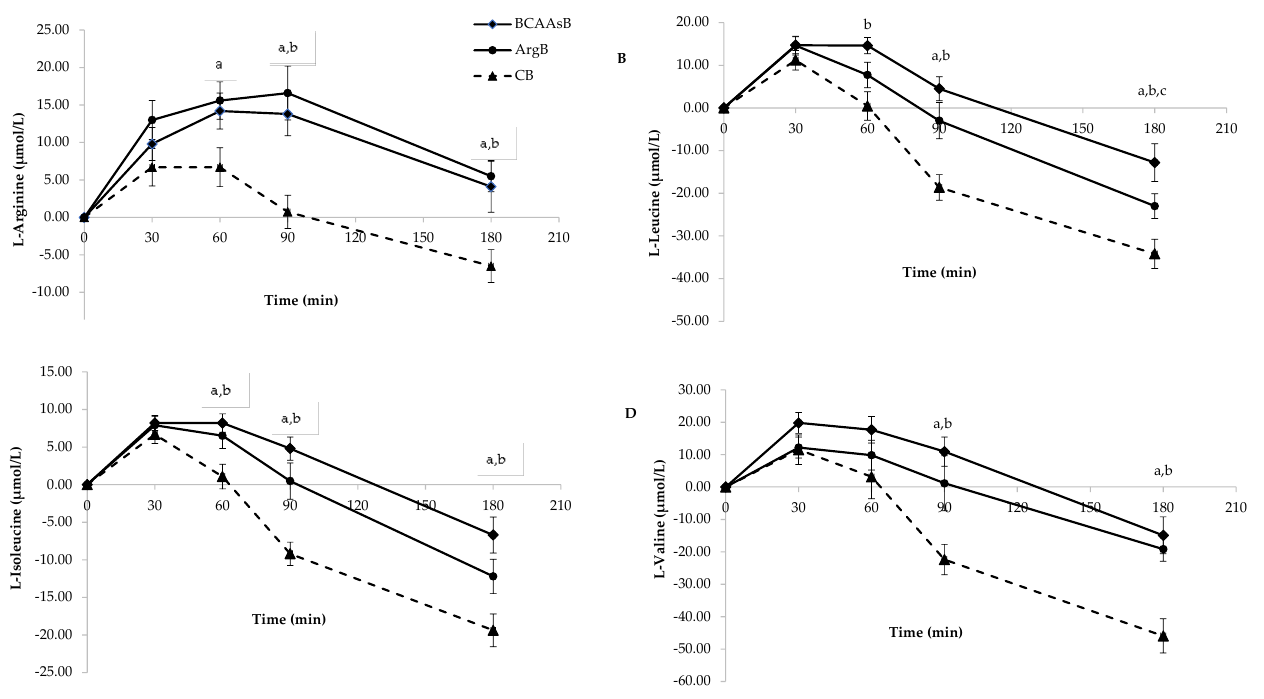
Table 4. Incremental areas under the curve (iAUCs) for L-arginine, L-isoleucine, L-leucine and L-valine after ingestion of the three biscuits.